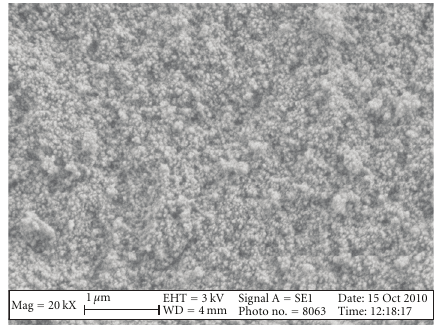
Figure 2: SEM pattern of Cu 2 O-TiO 2 .